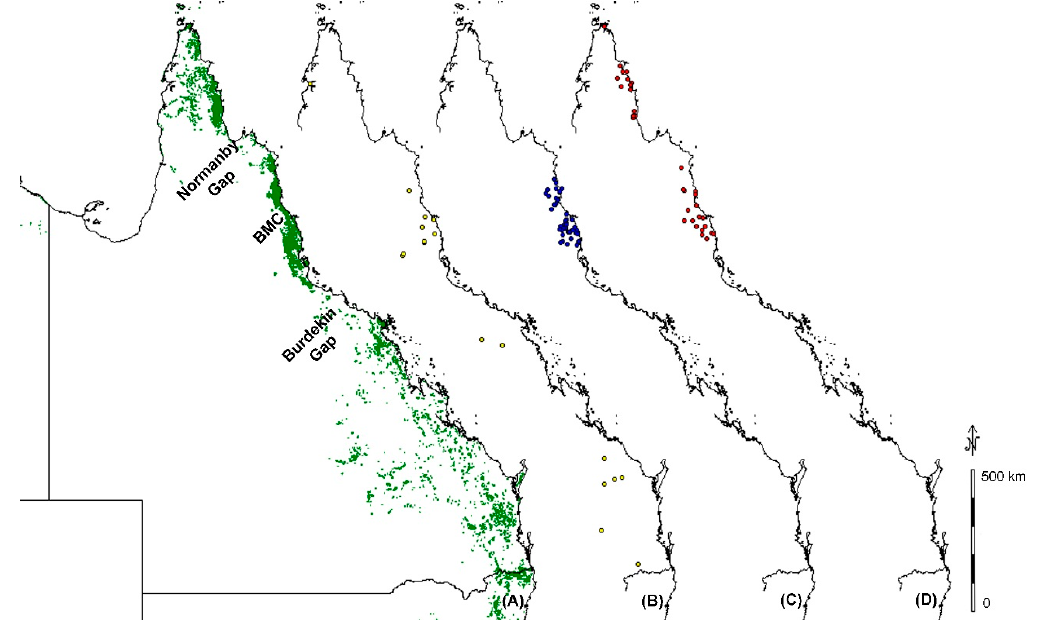
Figure 2. Extent of rain forest and vine thicket in Queensland shown in green ( A ); distribution of samples of variable species spanning the Burdekin Gap in yellow ( B ); the Black Mountain Corridor (BMC) in blue ( C ); and the Normanby Gap in red ( D ).